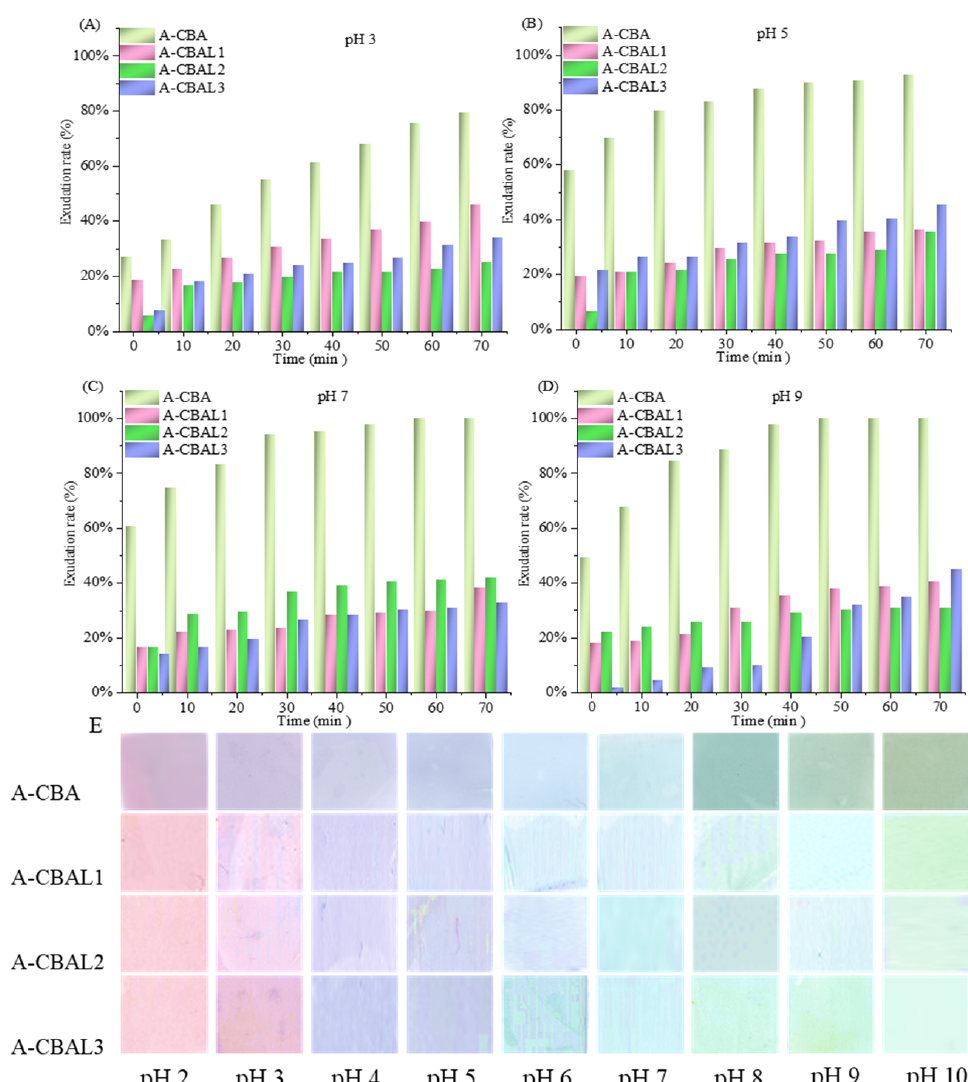
Figure 4. The exudation rates of bi-layer films at pH 3 ( A ), pH 5 ( B ), pH 7 ( C ), and pH 9 ( D ), and the color of the films at pH 2-10 ( E ).